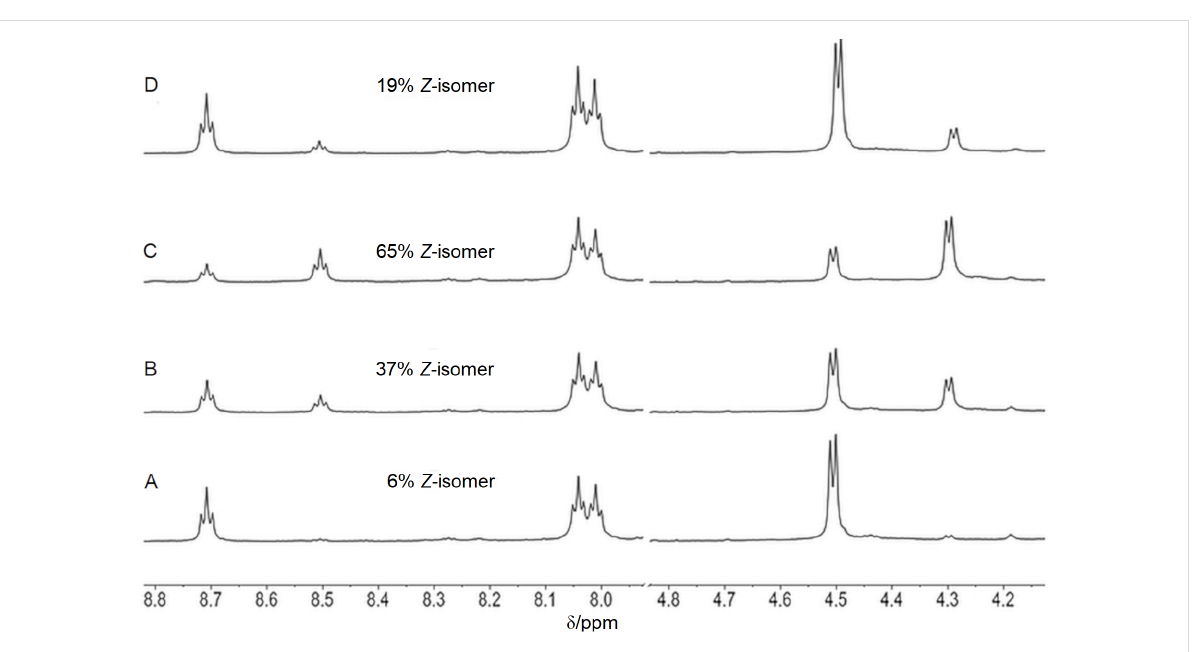
Figure 1: Section of the 1 H NMR (600 MHz) spectrum of polyamide P1 . A) Initial thermal equilibrium. B) After irradiation at 350 nm for 10 min. C) After irradiation at 350 nm for 50 min. D) After irradiation at 420 nm for 30 min (in DMSO- d 6 , c = 8 mM).